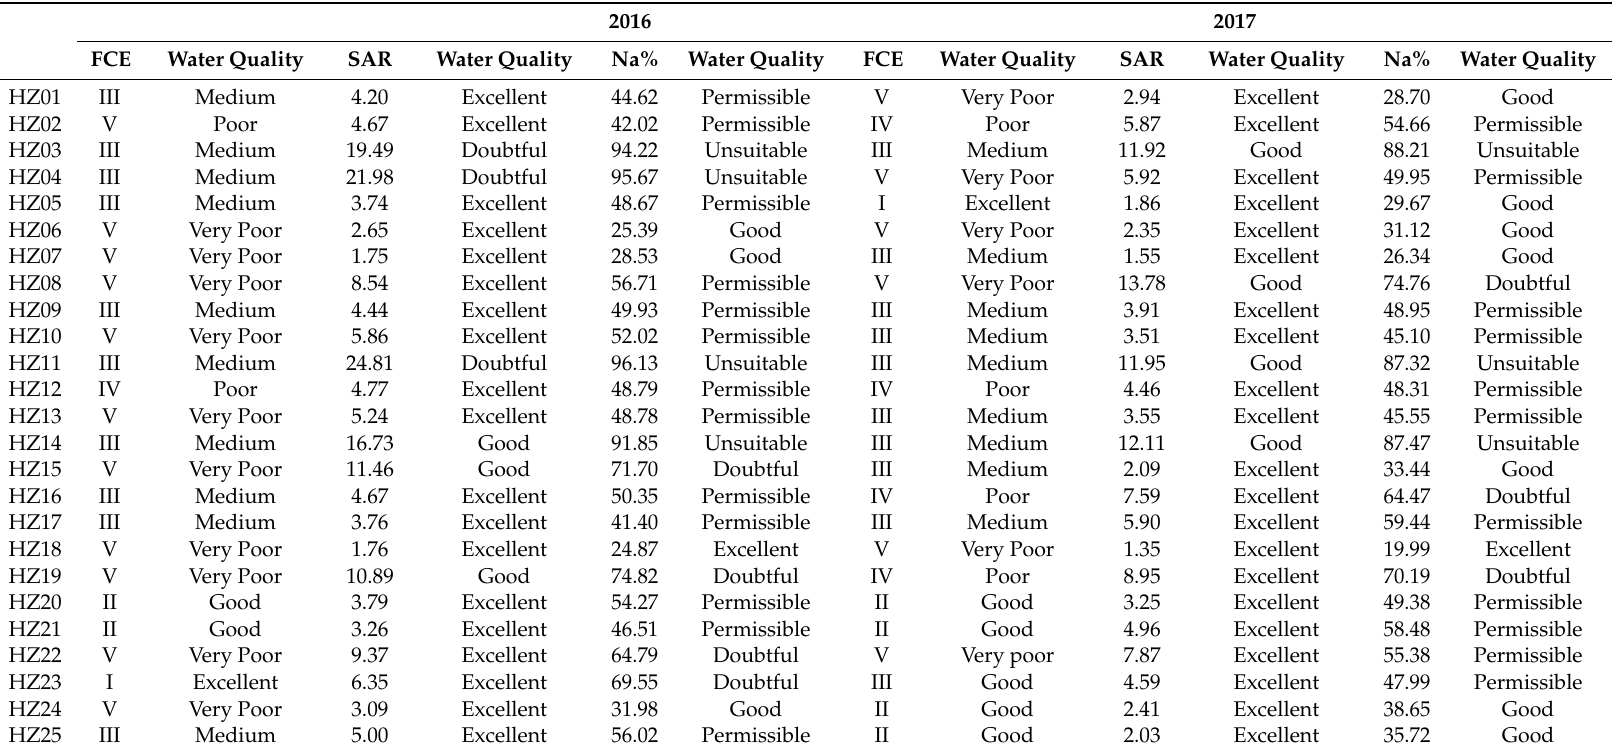
Table 5. Assessment results of the Fuzzy comprehensive evaluation (FCE), sodium adsorption ratio (SAR) and % Na value in 2016 and